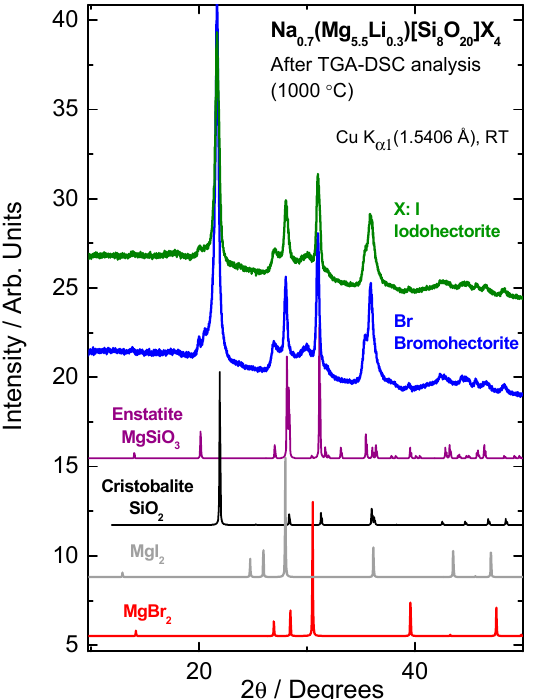
Figure A2. The XPD measurements of bromohectorite and iodohectorite after heating to 1000 °C.